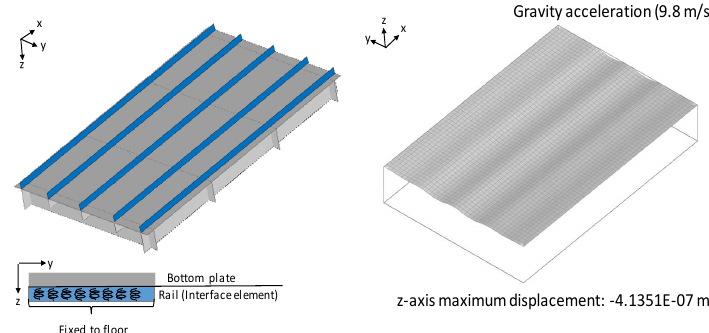
Figure 9. Effect of gravity on the bottom plate under the rail boundary condition. Figure 9. E ff ect of gravity on the bottom plate under the rail boundary